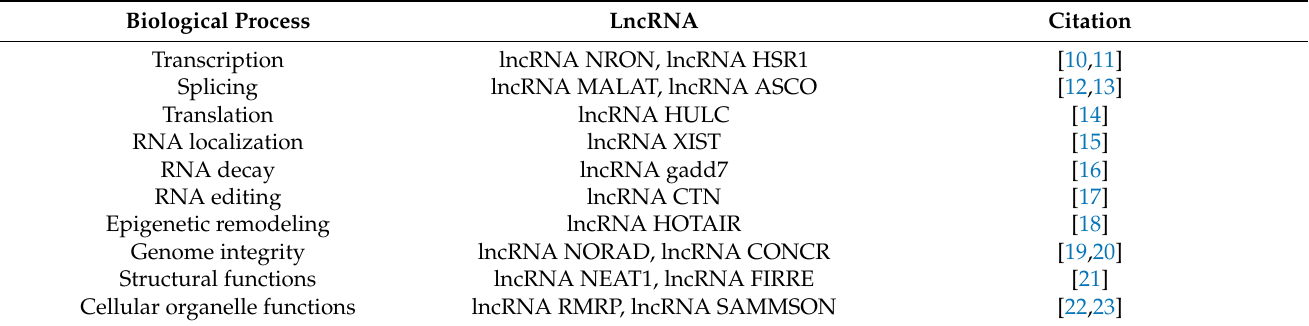
Table 1. Biological processes and examples of